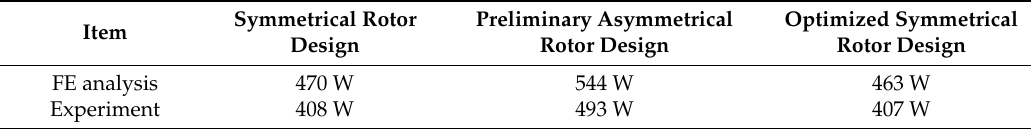
Table 4. Comparison of the iron loss results.